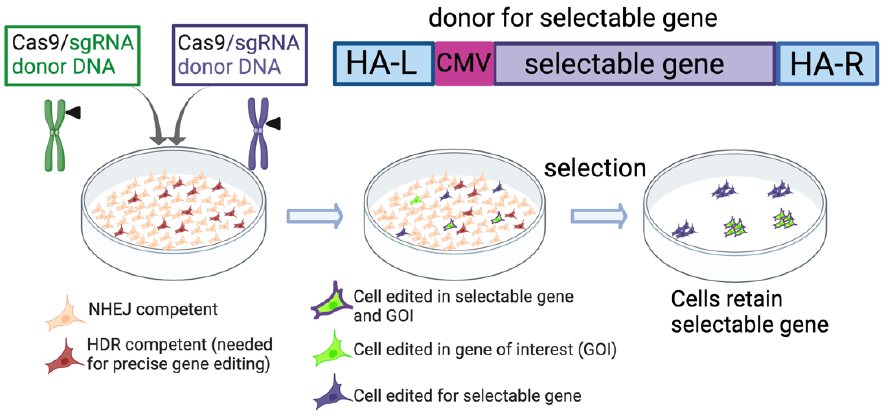
Figure 3. Selection marker co-edited with gene of interest. The selectable gene is edited into a locus independent of the gene of interest. Note that the donor construct elements are not to scale and depict a general approach. In this example, a CMV promoter is used to drive expression of the selectable gene. HA-L, HA-R; left and right homology arms, respectively. Created with BioRender.com .